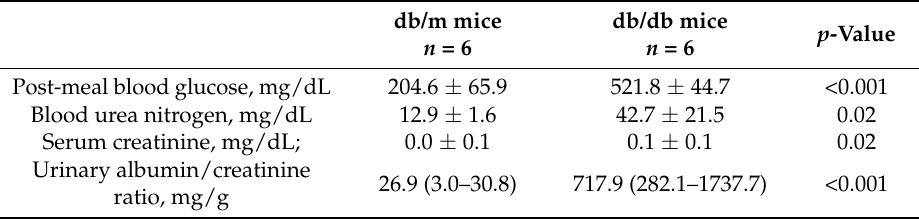
Table 4. The metabolic parameters of